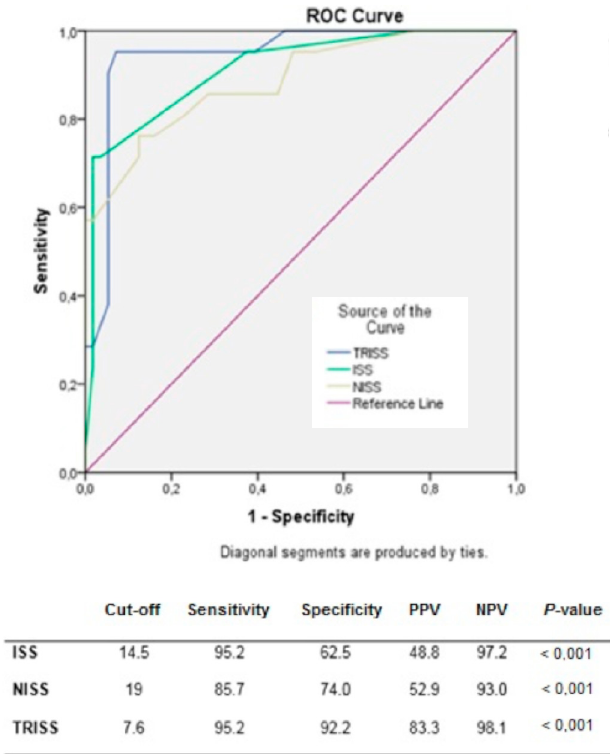
Fig. 1 – Receiver operating characteristic (ROC) analysis of ISS, NISS, and TRISS for the risk of mortality in cardiovascular injuries. Cut-off values of risk scores in the prediction of mortality. ISS=Injury Severity Score; NISS=New Injury Severity Score; NPV=negative predictive value; PPV=positive predictive value; TRISS=Trauma and Injury Severity